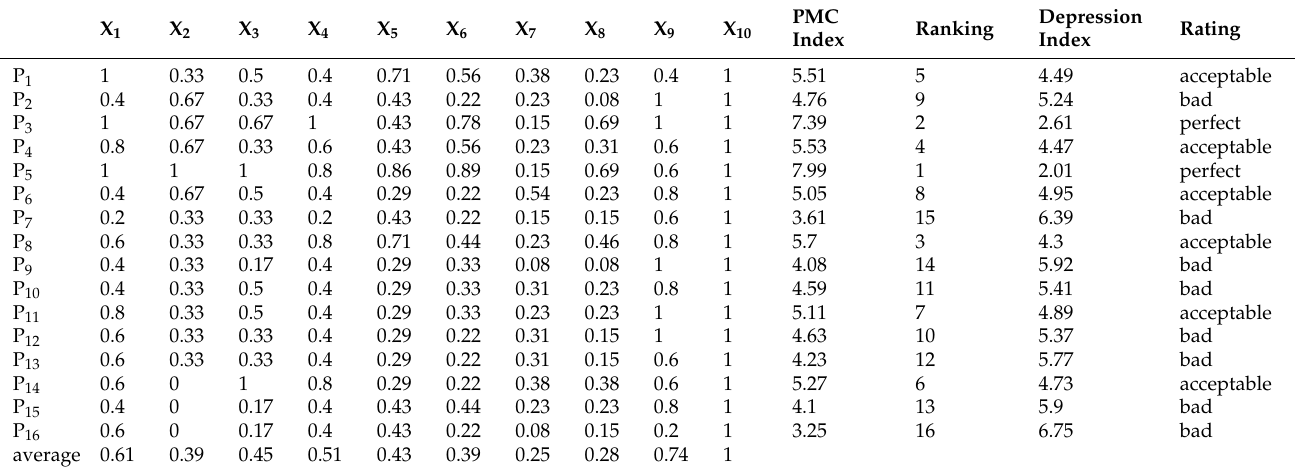
Table 5. PMC index of employment promotion policy documents for college